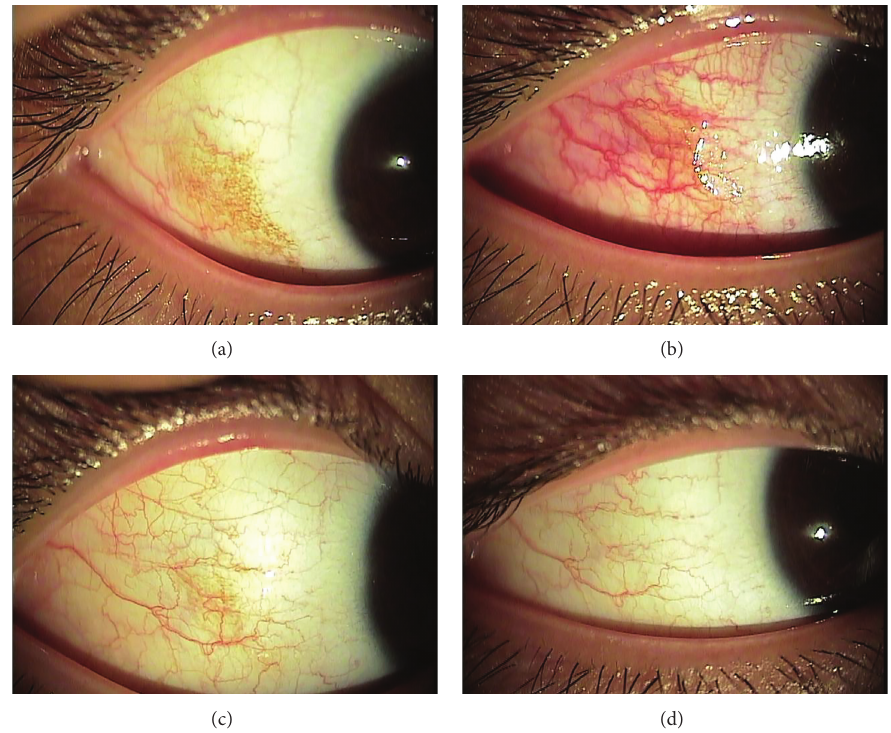
Figure 1: Anterior segment photographs obtained before and after the two argon laser photoablation sessions for postburn conjunctival pigmentation.(a)Pretreatmentphotographshowingconjunctivalpigmentationonthetemporalsideoftherighteye.(b)Immediatelyafterthe first argon laser photoablation session, approximately half of the pigmentation had been removed, leaving a conjunctival defect. Conjunctival injection around the laser-treated area is apparent. (c) One week after the first laser treatment, conjunctival injection had resolved and the remaining conjunctival pigmentation was removed with another argon laser photoablation session. (d) One month after the last treatment, no residual pigmentation, injection, or scarring of the temporal conjunctiva was